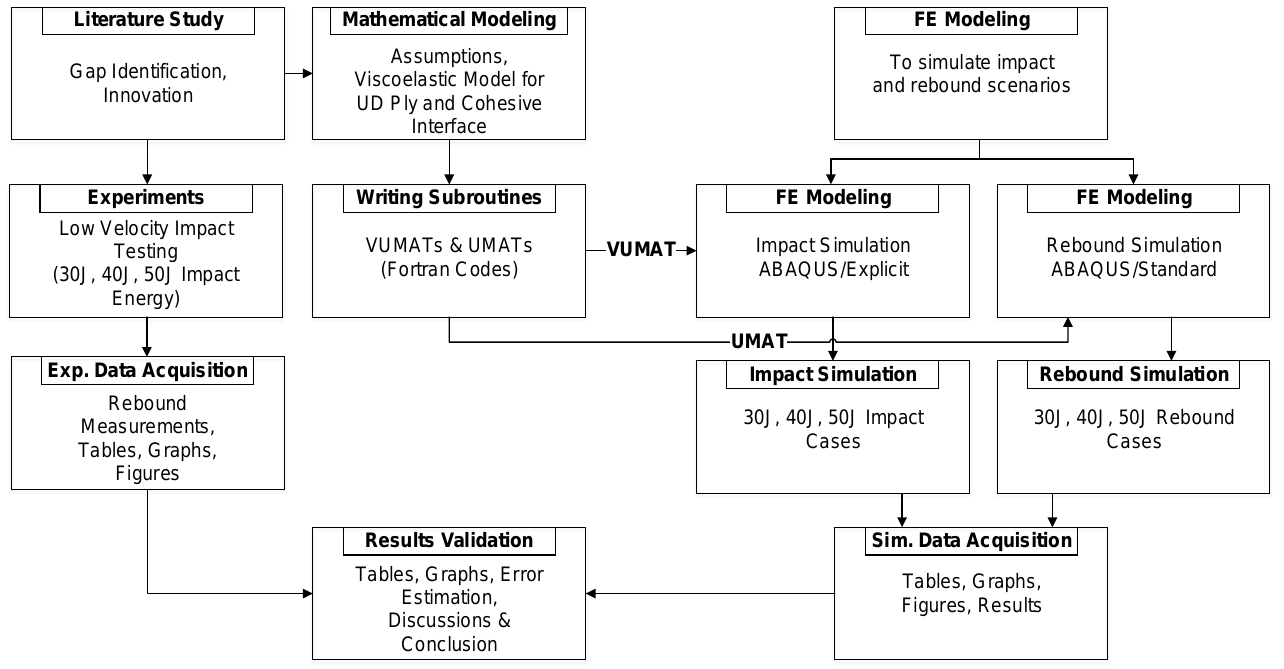
Figure 1. Schematic of the Overall Methodology or Research Flow.